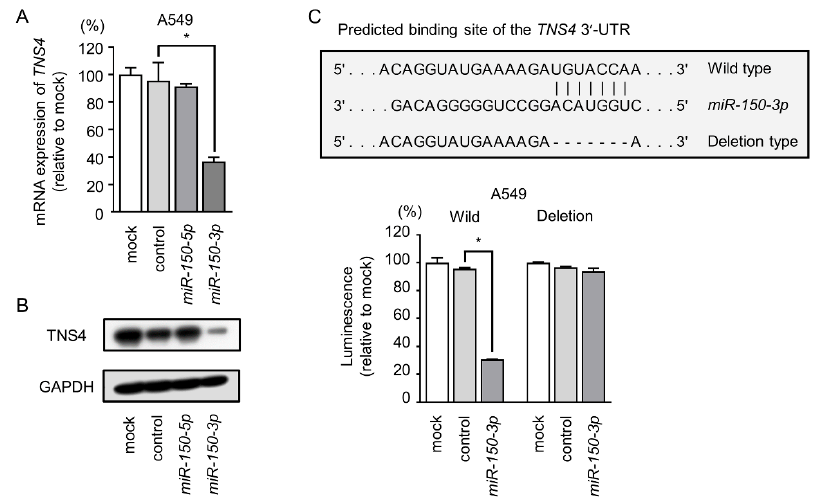
Figure 4. TNS4 was directly controlled by miR-150-3p in LUAD cells. ( A , B ) TNS4 mRNA and protein